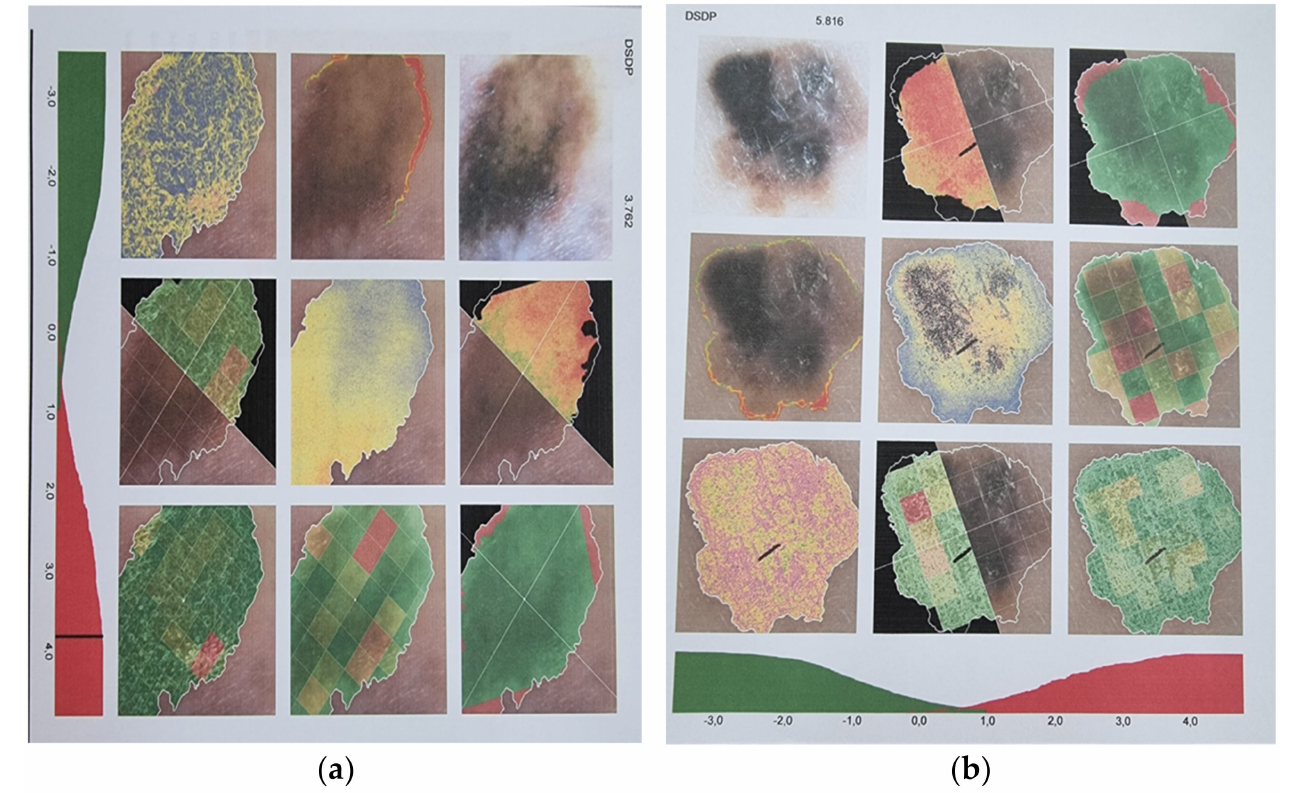
Figure 1. Cutaneous malignant melanomas ( a , b ), as seen with the help of digital dermatoscopy, illustrating aspects of polarized light, color, form, margins, number of colors, color homogeneity, number of structures, structure asymmetry, and structure